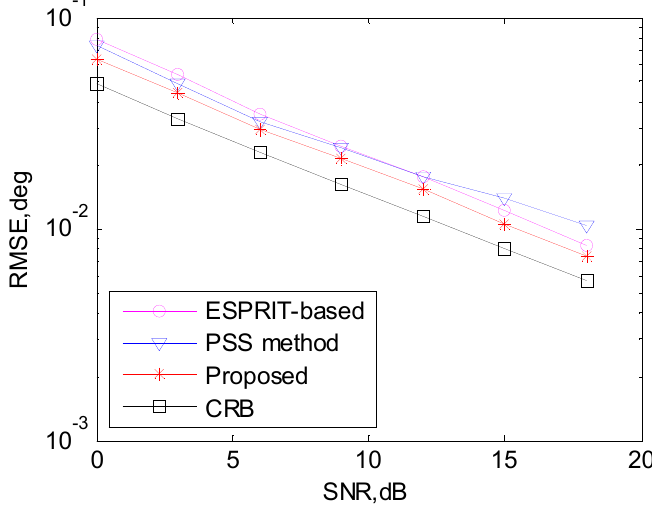
Figure 3. DOA estimation performance comparison.